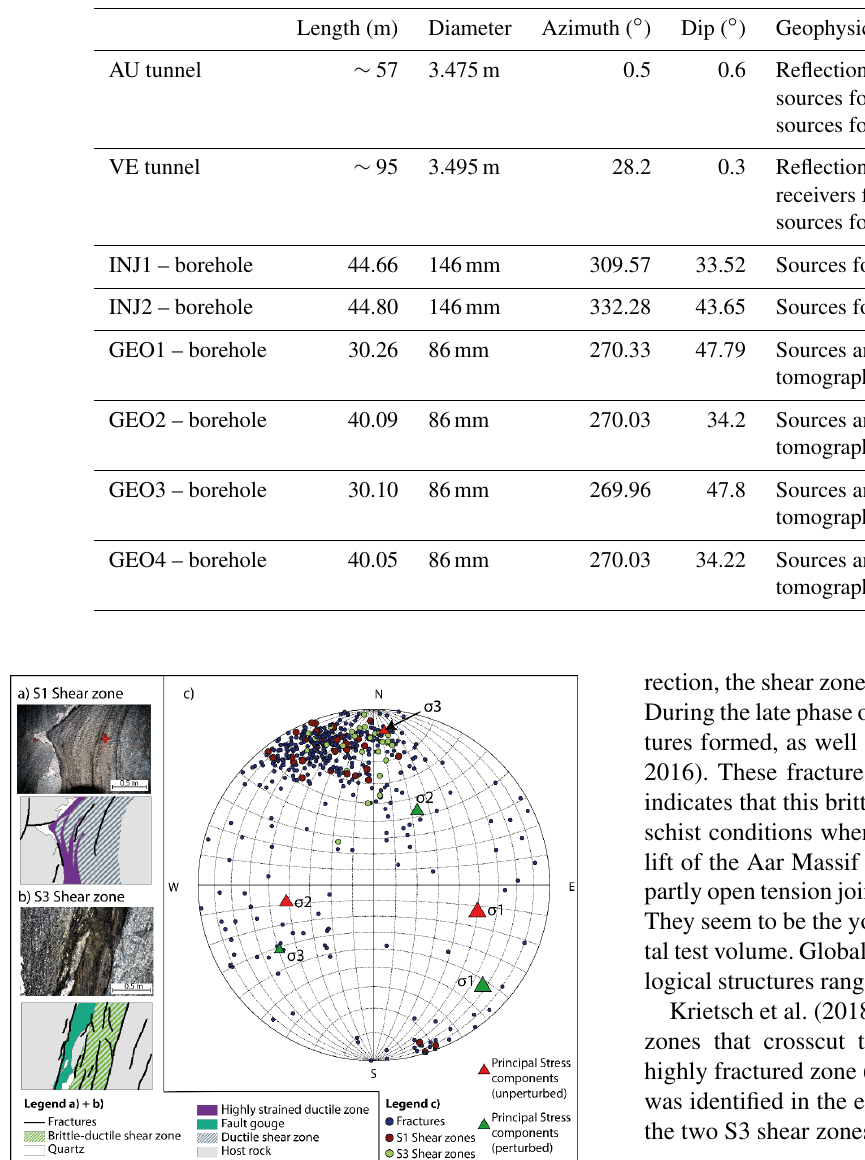
Table 1. Overview of tunnels and boreholes used for geophysical measurements.